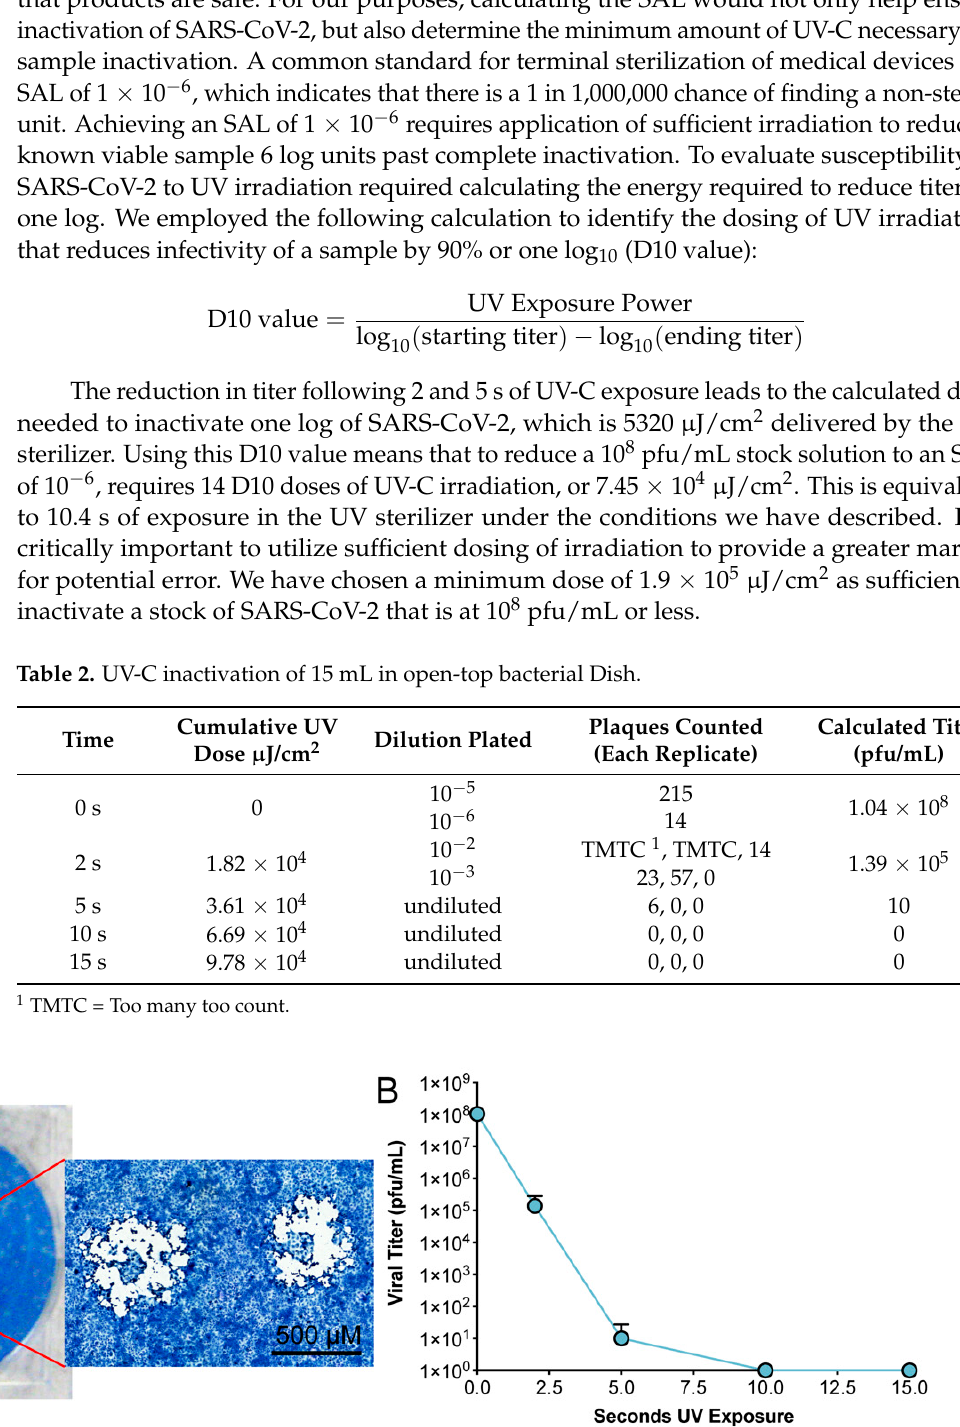
Figure 1. Plaque analysis and UV inactivation. ( A ) Infectious viral particles were detected by plaque assay under methylcellulose. Depicted is a single well of a six-well plate that had been inoculated with a limiting dilution of infectious viral stock. The inset is a higher magnification image of representative SARS-CoV-2 plaques. ( B ) A clarified solution containing infectious SARS-CoV-2 was subjected to UV exposure as detailed in Materials and Methods. Samples were taken from triplicate conditions at sequential exposures to UV-C irradiation. Each sample was then assessed for infectivity by the previously described plaque assay.